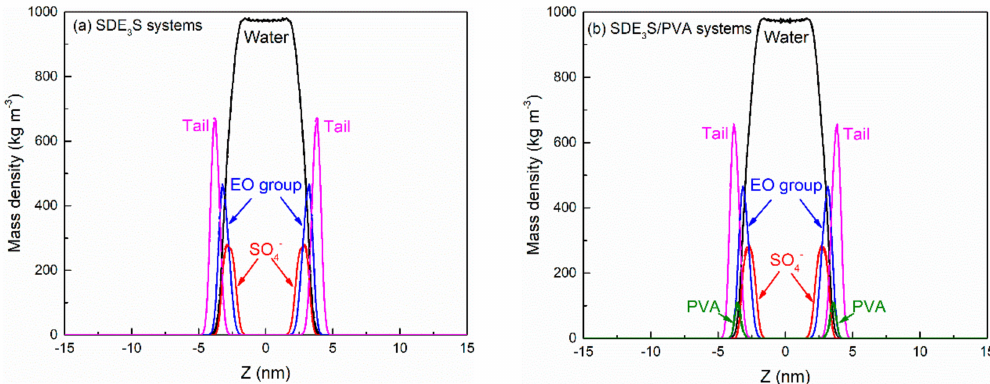
Figure 6. Mass density profiles of ( a ) SDE 3 S systems and ( b ) SDE 3 S / PVA systems over both 30–40 ns (solid lines) and 40–50 ns (dashed lines) at the SDE 3 S adsorption density of 3.23 µ mol / m 2